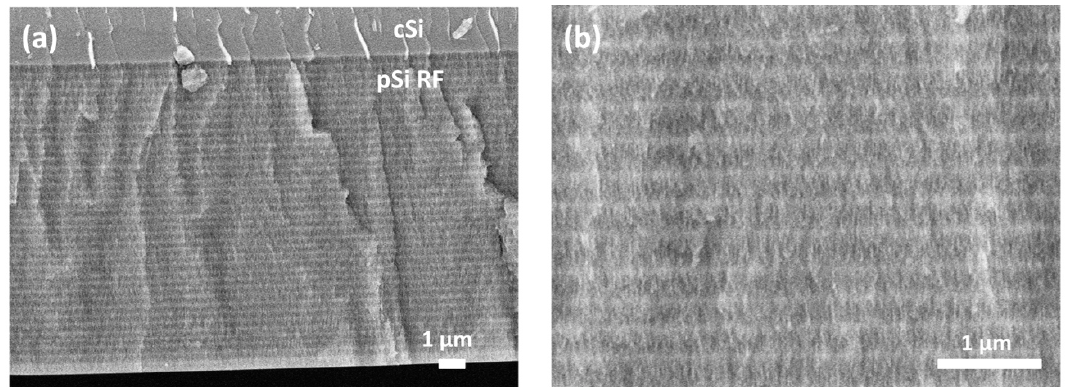
Figure 5. Cross-section FE-SEM images of an RF S2 consisting of 40 cycles recorded with two magnifications. (a) Low magnification image showing the whole rugate filter structure (b) High magnificationimage showing zones of different porosities in more detail.